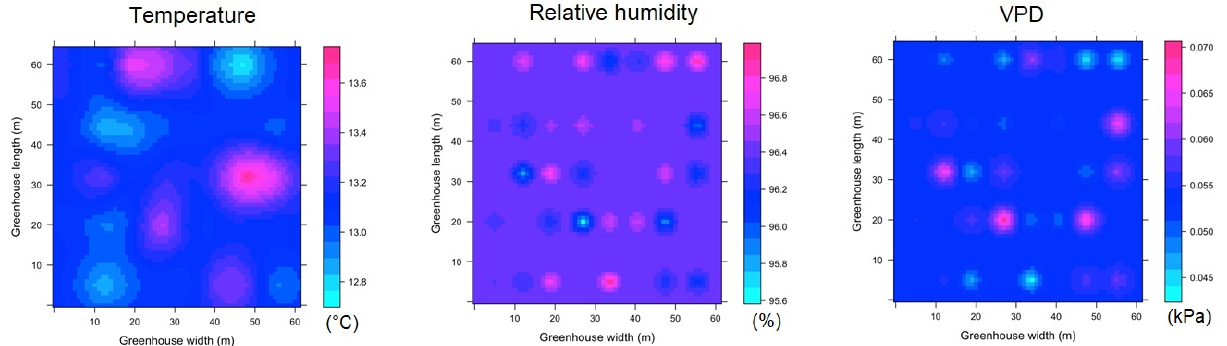
Figure A4. Spatial distribution predicted by kriging, for temperature, relative humidity and VPD in TG and for ESRL 2.